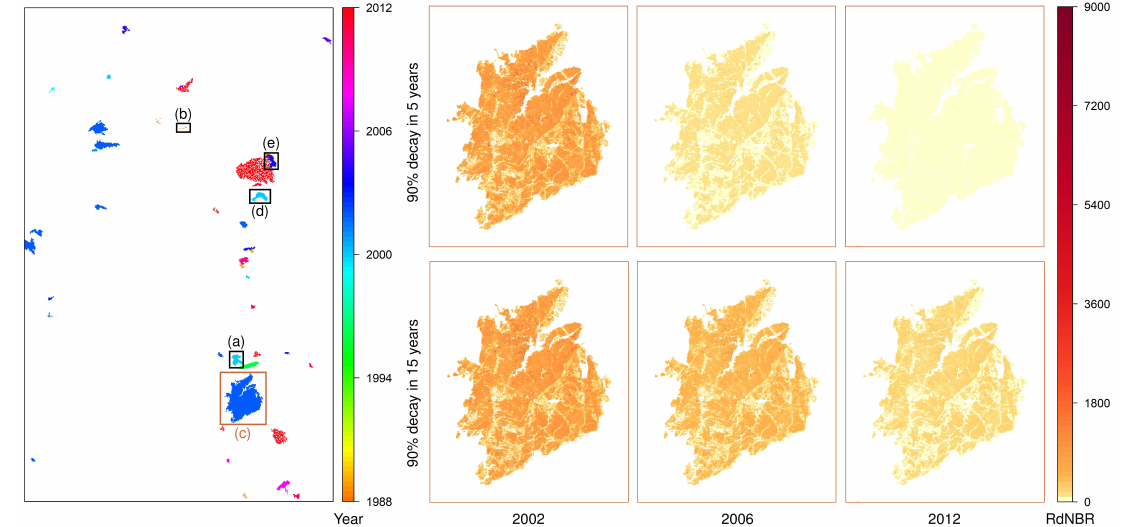
Figure A3. Fire affected areas in the region of interest with color indicating the year of ignition (left panel). The fire areas surrounded by rectangles in the left panel correspond to the fires in Figure A2, and the naming convention ( a – e ) matches the one used in Figure A2. RdNBR values for fire ( c ) for the years 2002, 2006, and 2012 are shown in the six panels on the right. The top row represents the case when the RdNBR values are accumulated over time with θ = 2.17, and the bottom row represents the case when θ =